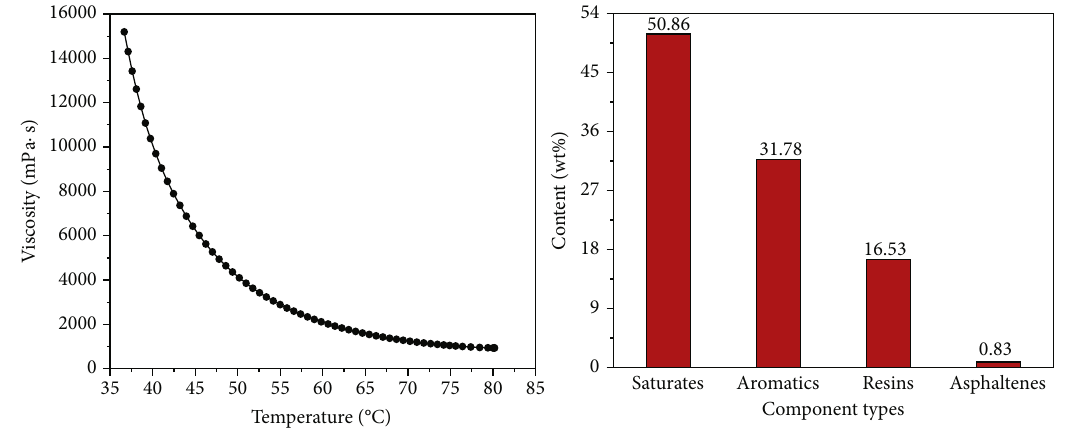
Figure 1: Viscosity-temperature curve and the content of four components of crude